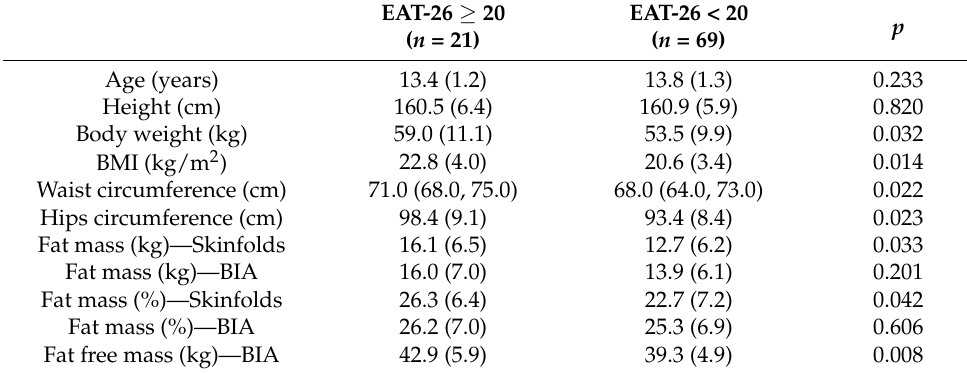
Table 5. Participants’ anthropometric characteristics according to the EAT-26